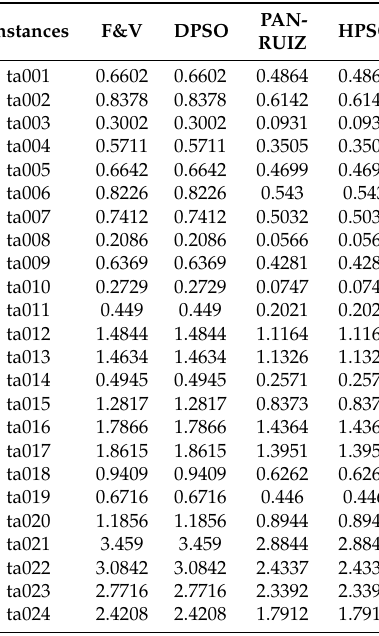
Table 3. Comparison of performance of the existing metaheuristics and